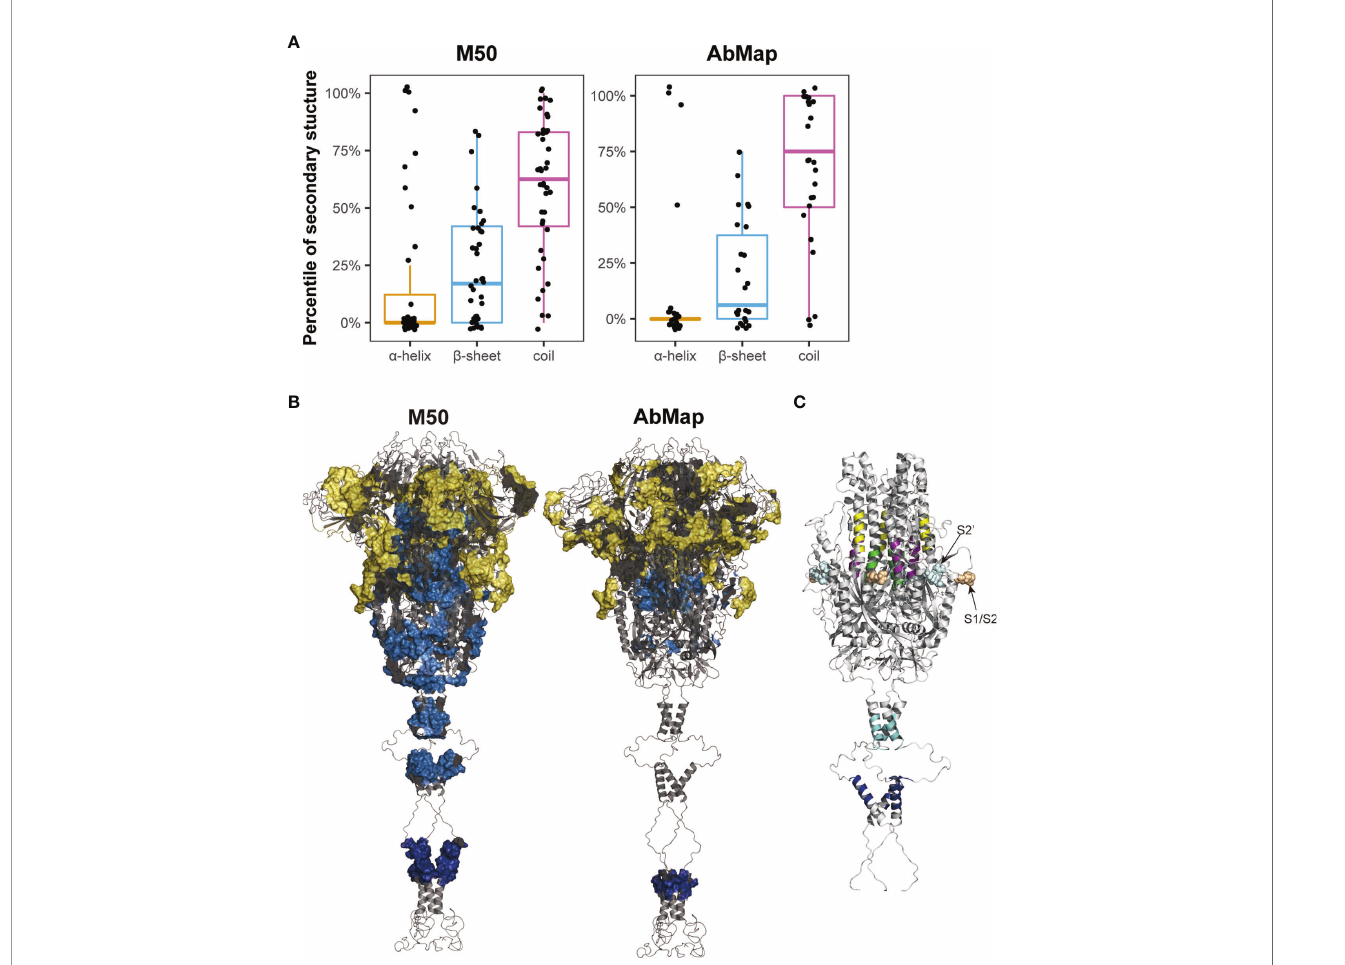
FIGURE 5 | Spatial characteristic of the epitopes on S protein. (A) Distribution of secondary structures ( a -helix, b -sheet, and random coil) analyzed by DSSP in M50 S peptides based on the microarray and 24 epitopes identi fi ed by AbMap. The y axis represents the percentiles of secondary structures in each of the S epitopes. (B) Spatial localization of the epitopes identi fi ed by the microarray (M50) (left) and AbMap (right) analysis on the trimer model of the S protein (side view). The backbone structure is illustrated in the gray cartoon mode. Each set of epitopes are highlighted on the surface. Epitopes located in the S1, S2, and transmembrane regions are shown in yellow, light blue, and dark blue, respectively. (C) Spatial localization of the fi ve S epitopes with a -helical structures on the trimer model of S2 protein. Stalk region of the S2 protein is shown in gray cartoon. The fi ve peptide epitopes, namely, S2-15, S2-45, S2-56, S2-78, and S2-83 are shown in purple, yellow, green, cyan, and blue